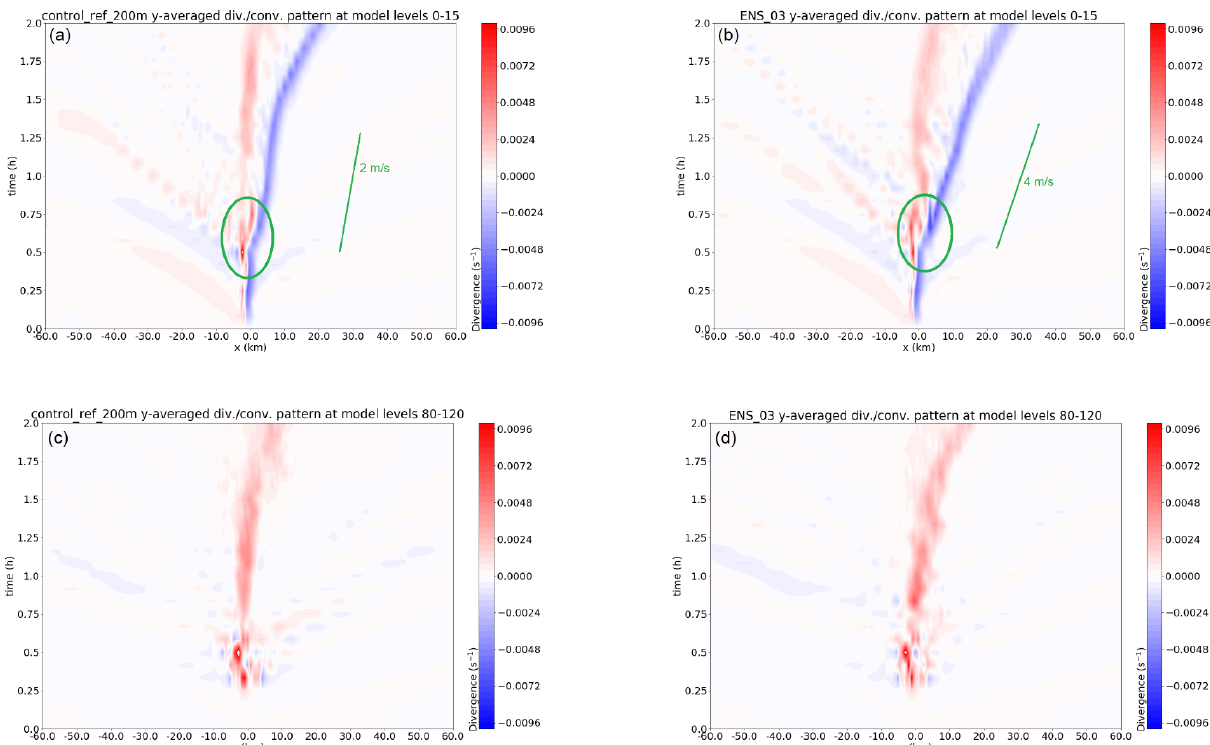
Figure 3. Space–time distribution of low-level (0–1.5km; a, b ) and upper tropospheric (8–12km; c, d ) convergence ( s − 1 ) features in the reference simulation (a, c) and ensemble member 3 (b, d) , averaged over all y and given z . A stage of particular interest that is analysed in the text is highlighted with a green oval, as well as the slope of the convergence zones halfway through the